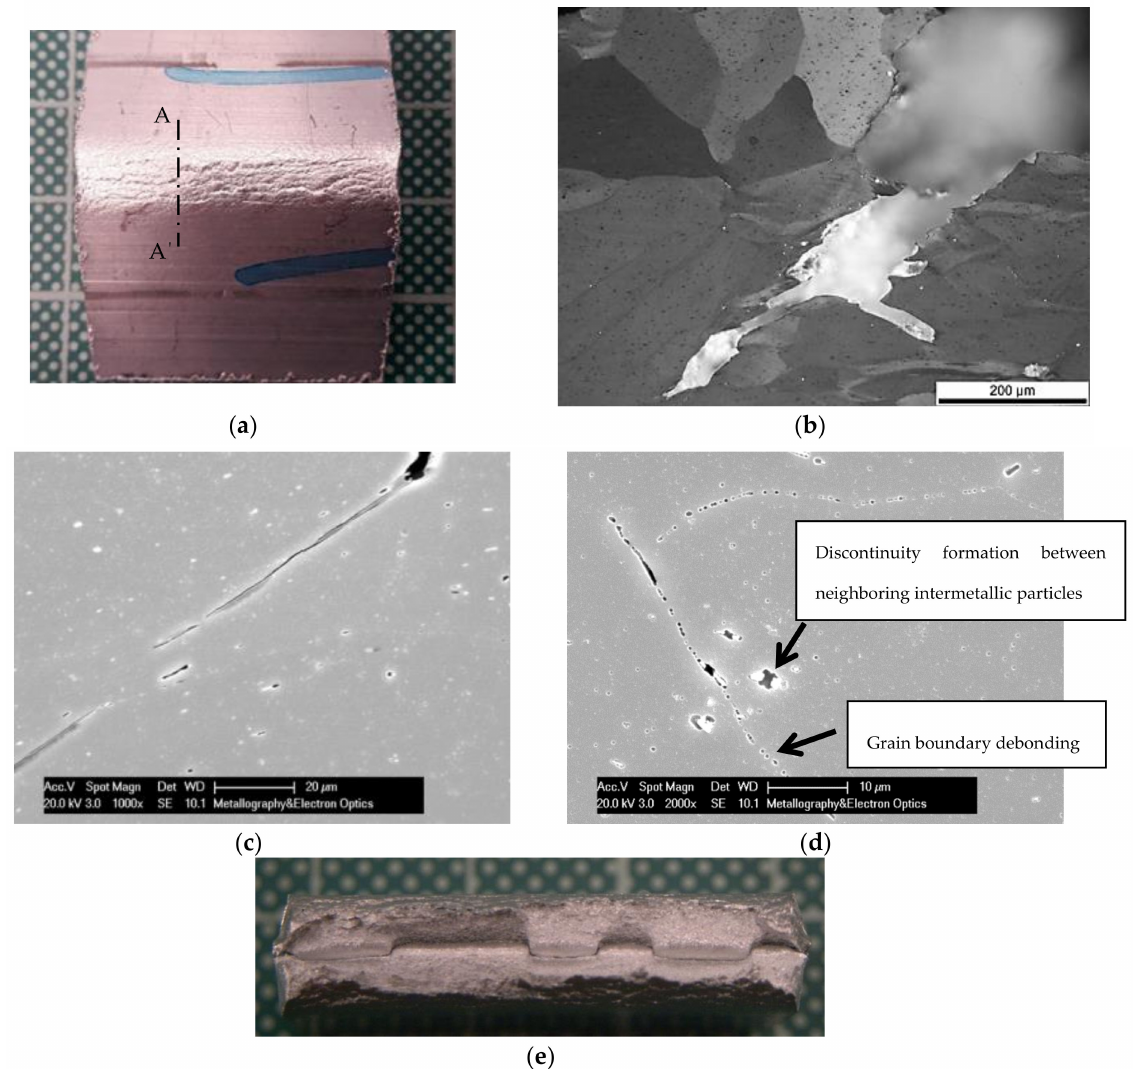
Figure 10. ( a ) Macroscopic image of bent specimen sample with 2.9 mm thickness (end of bending test at 10% load drop, transverse bend test with bend line parallel to extrusion direction). ( b ) Optical micrograph, cross-section A-A’ showing heavy, partly intergranular cracking on the surface. ( c , d ) SEM micrographs, grain boundary debonding and rupture. ( e ) Macrograph, end of bending test at 180